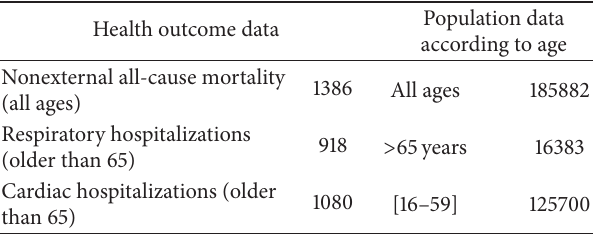
Table 3: Health outcome and relative risk used in this HIA in 2014.